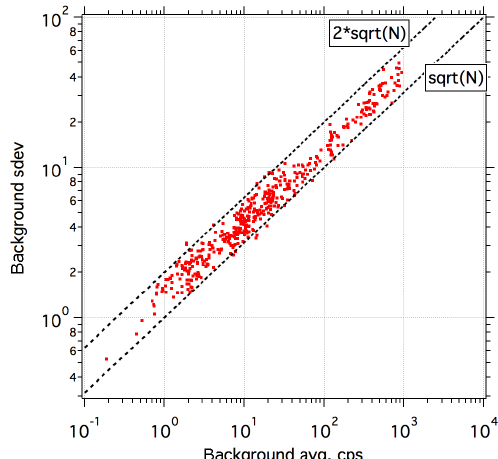
Figure 9. Scatterplot of the standard deviations of background signals vs. the measured background signals from a flight on 27 April 2015 during SONGNEX. In this graph, the signals are not corrected for the ToF duty cycle to better reflect the counting statistics of the ToF √ ×√ N and 2 N detector. The two dashed lines are